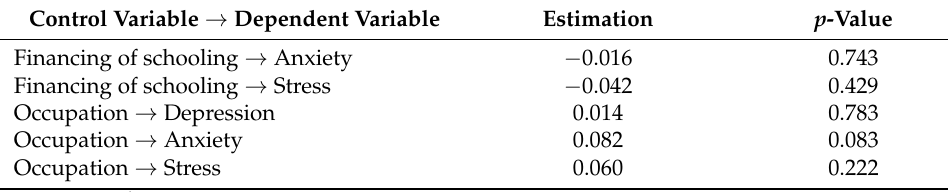
Table 3. Cont. Control Variable → Dependent Variable